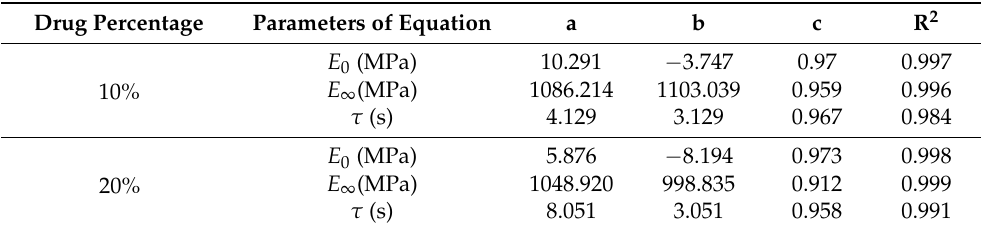
Figure 11. Relationship between the values of ( a ) elastic and ( b ) viscous modulus and ( c ) relaxation time with the time of release and drug percentage. Table 2. Parameters of the relationship between the values of elastic and viscous modulus and relaxation time with the time of release and drug percentage.